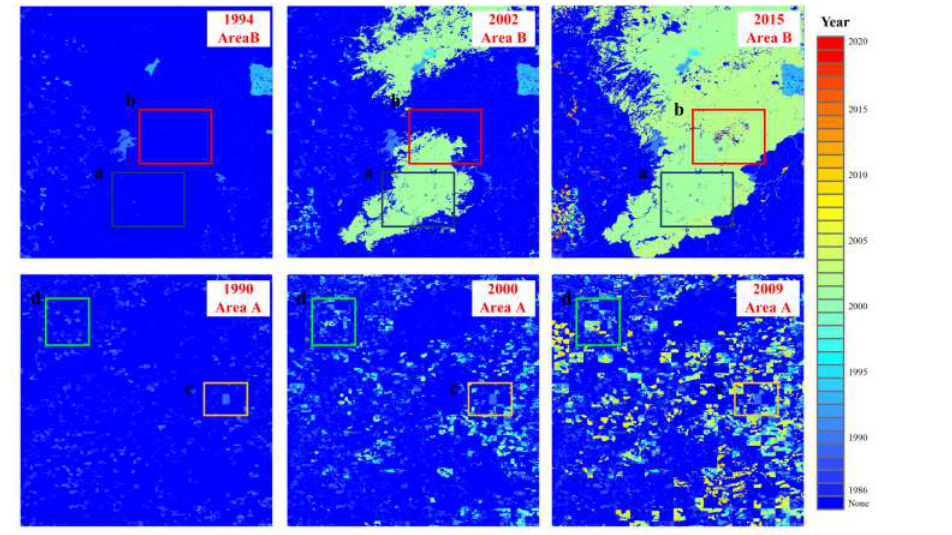
Figure 8. Disturbance point detection results on area A and B. For area A, maps with forest fire in years of 1994–2002–2015 are illustrated. For area B, maps with harvest/deforestation in years of 1990–2000–2009 are illustrated.